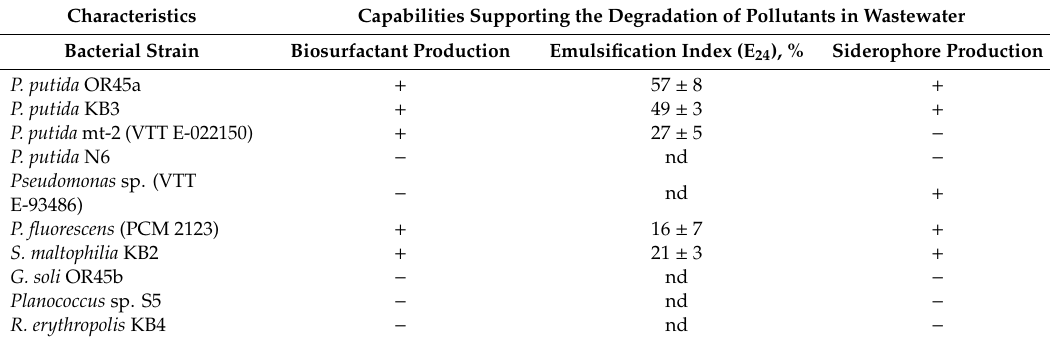
Table 3. Biosurfactant production, emulsification index, and siderophore production by the tested strains.